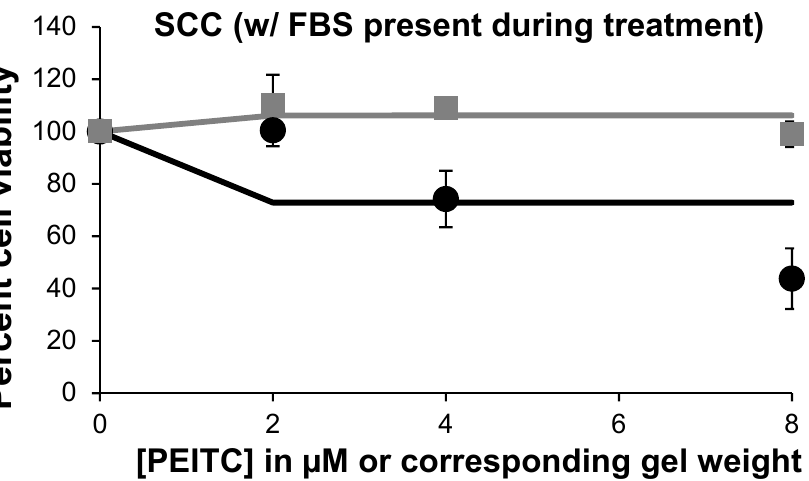
Figure 5. Dose-responses with treatment of phenethyl isothiocyanate (PEITC) carbomer gel at concentrations of 2, 4, and 8 µM PEITC and blank carbomer gel at corresponding masses. Blank carbomer gel toxicities are shown with gray square markers and the gray line, and PEITC carbomer gel toxicities are shown with black circles and the black line. These SCC-25 cells were treated with the presence of FBS.